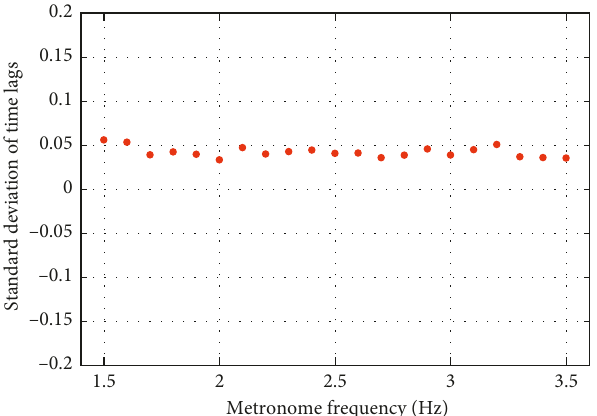
Figure 16: Standard deviation of the time lags of all participants identified for the reference configuration.